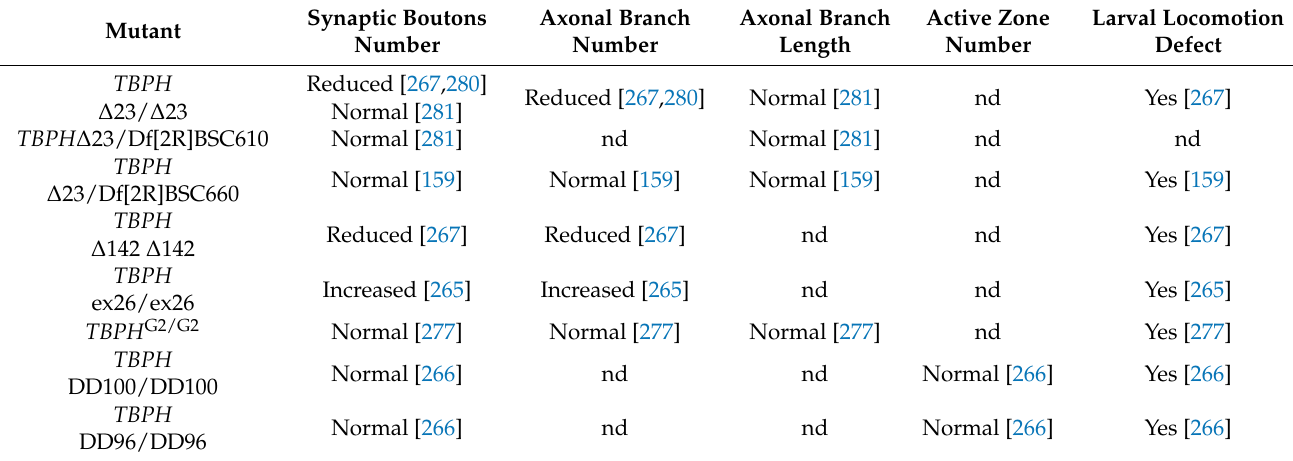
Table 7. Phenotypes at larval neuromuscular junction of TBPH